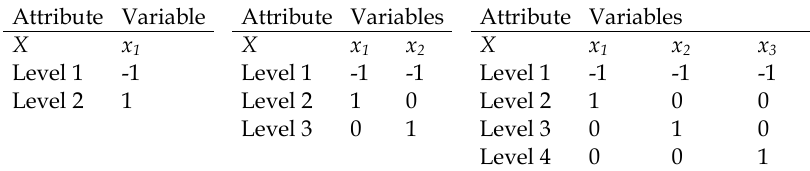
Table 2. Effects coding for attributes with two, three and four levels (each attribute requires a number of auxiliary variables equal to the number of levels minus one)